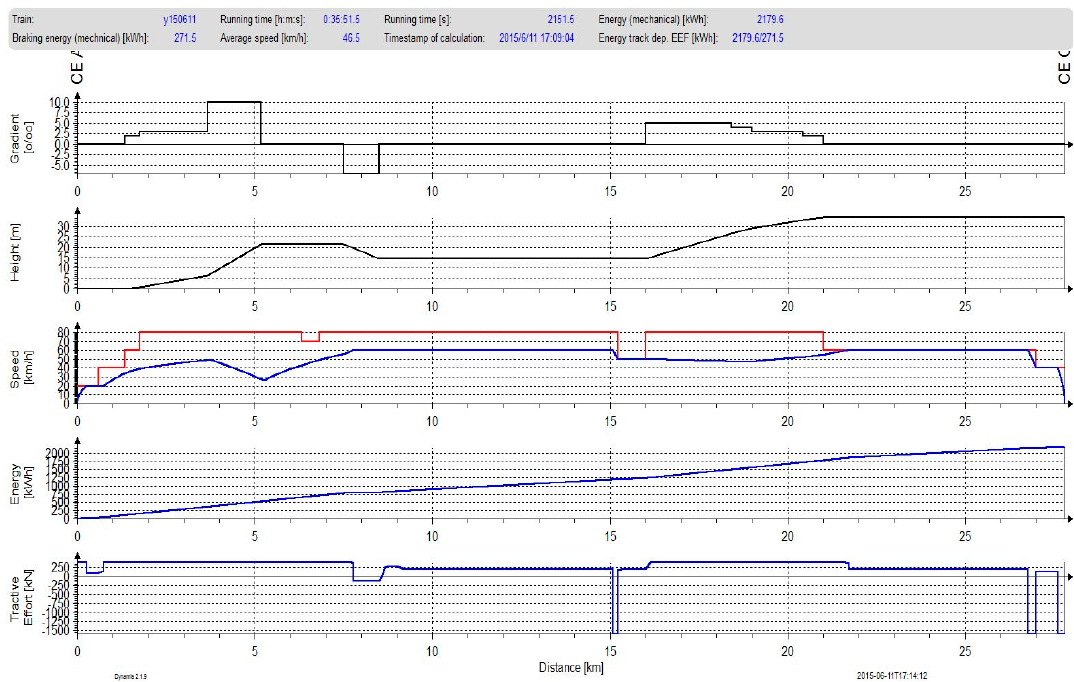
Figure 18. Speed profile optimization by Dynamis 2.0.